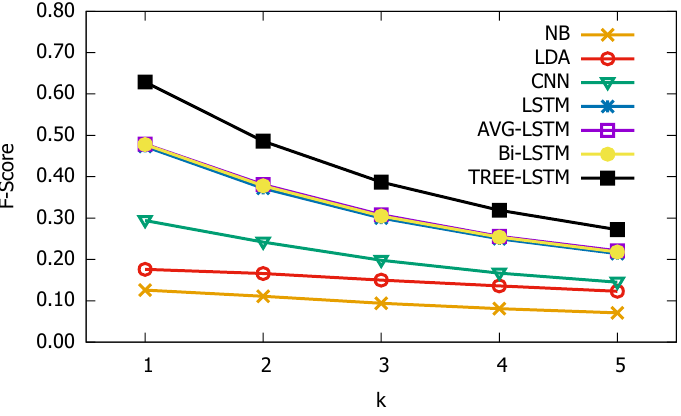
Figure 15. F1 values with recommended hashtags range from 1 to 5 in Twitter dataset.